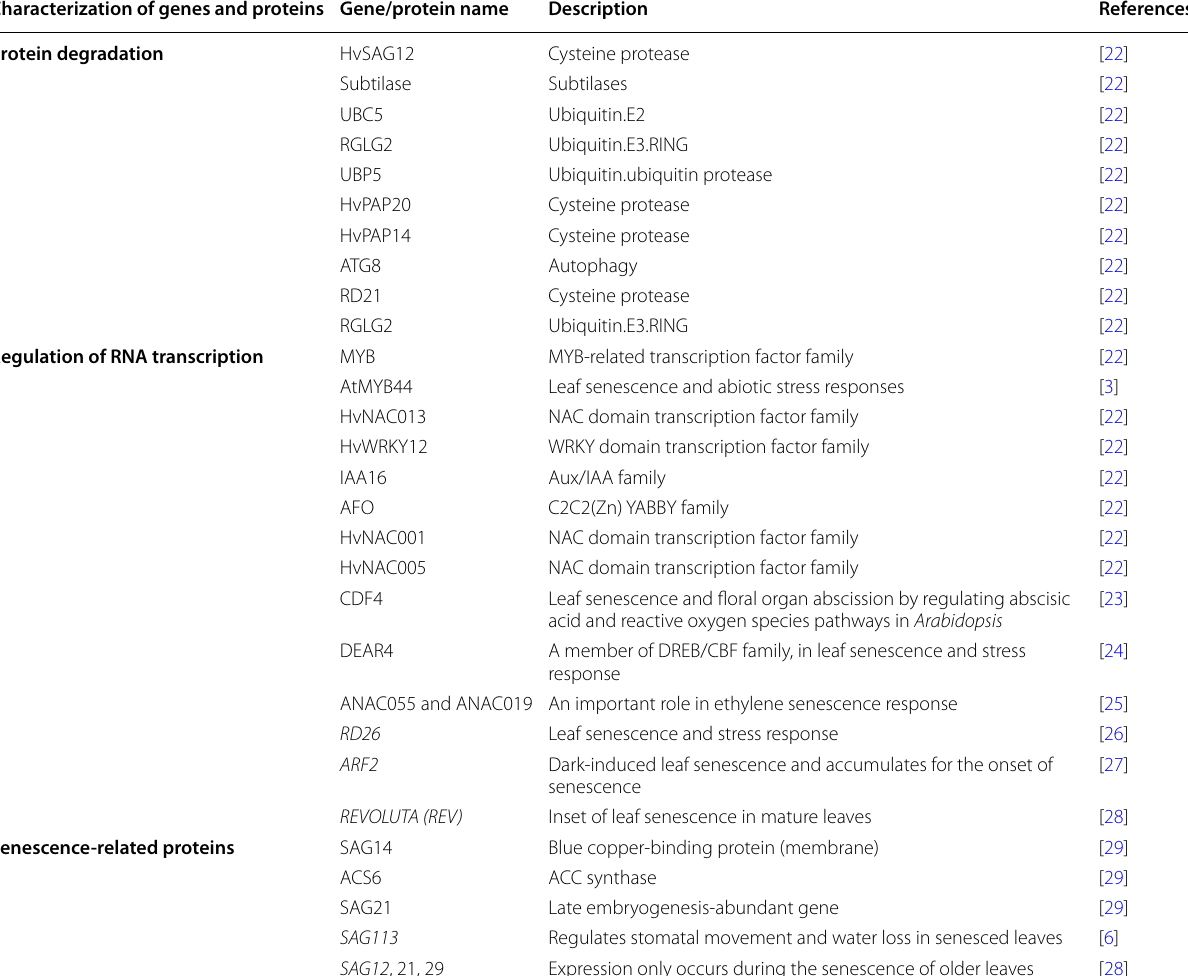
Table 1 Genes and proteins involved in leaf senescence Characterization of genes and proteins Gene/protein